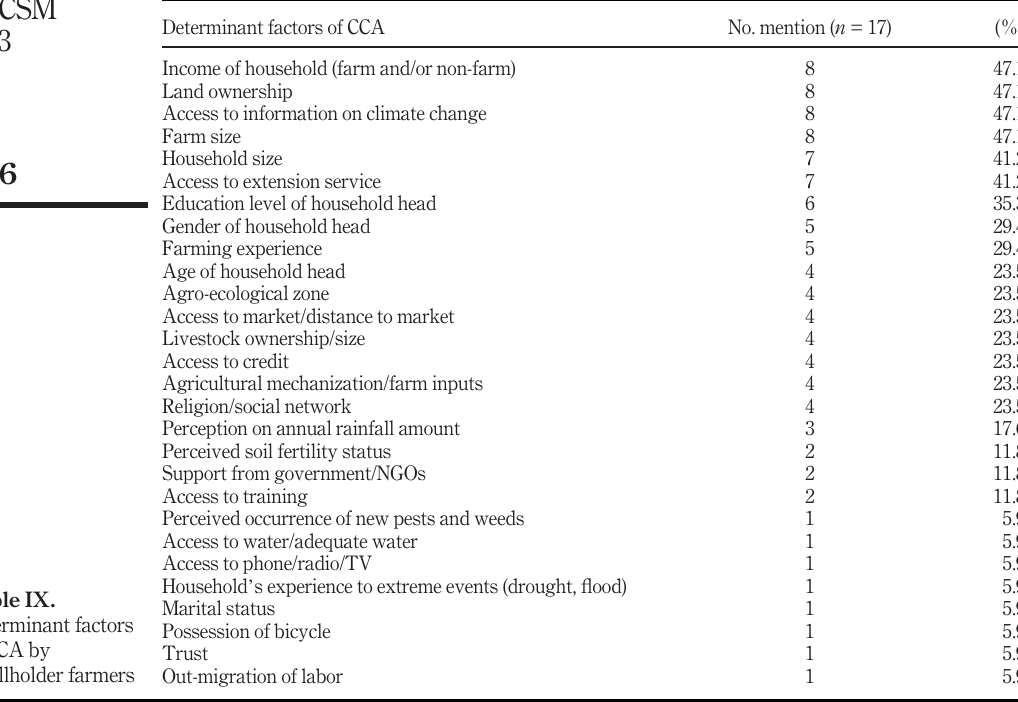
of CCA by smallholder